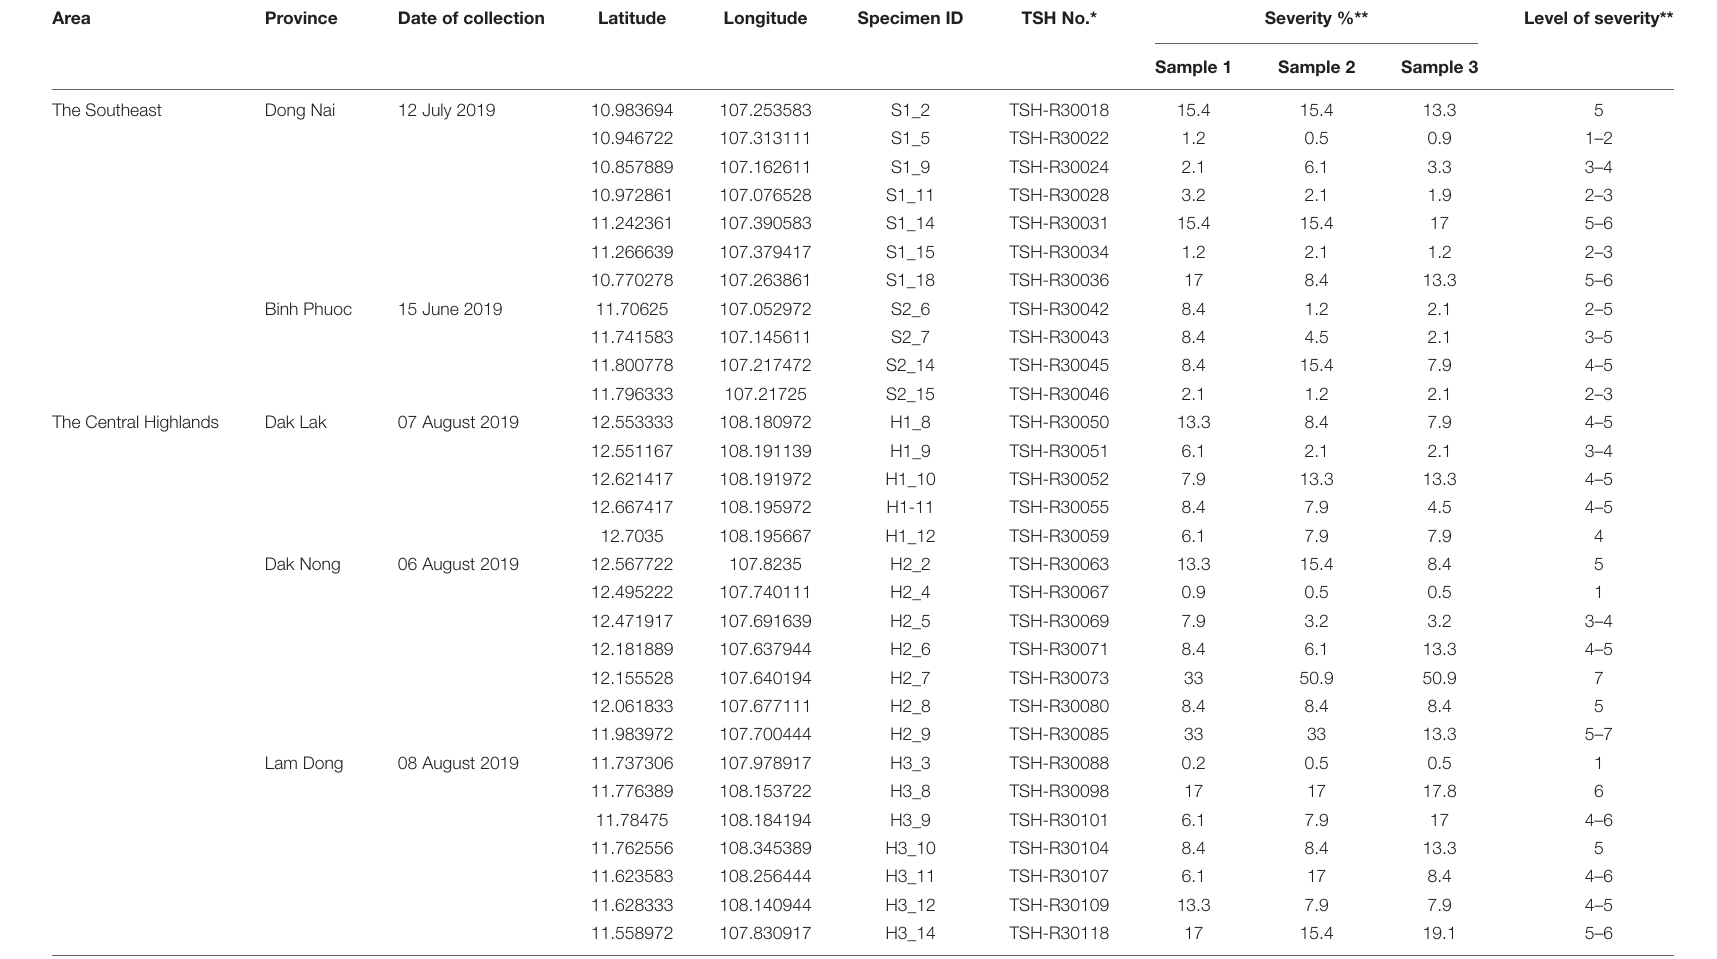
TABLE 1 | Coffee leaf rust samples collected in Vietnam and